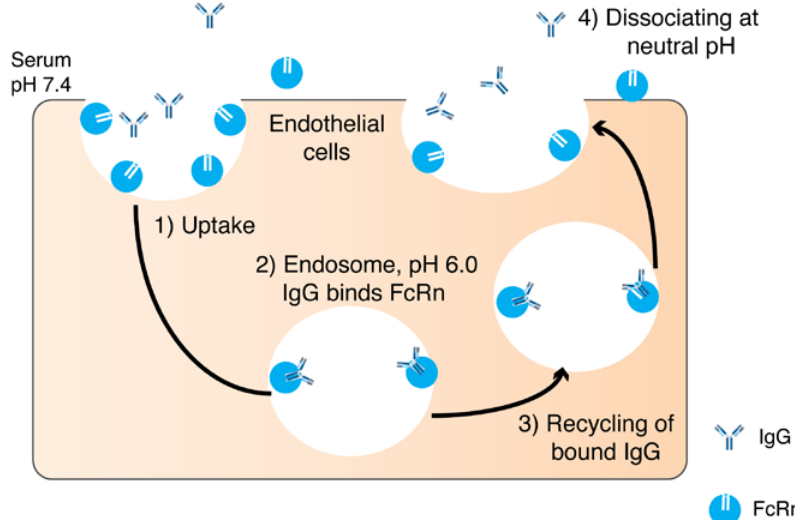
Figure 2. A schematic diagram illustrating neonatal Fc receptor (FcRn) recycling pathway: ( 1 ) Immunoglobulin G ( IgGs) are internaliszed into endocytic vesicles. ( 2 ) Endosome becomes acidic resulting in the binding of Fc domain to FcRn. ( 3 ) Bound IgG are recycled back to the cell membrane and ( 4 ) IgG dissociates at neutral pH (7.4) from FcRn and is released back into the blood.